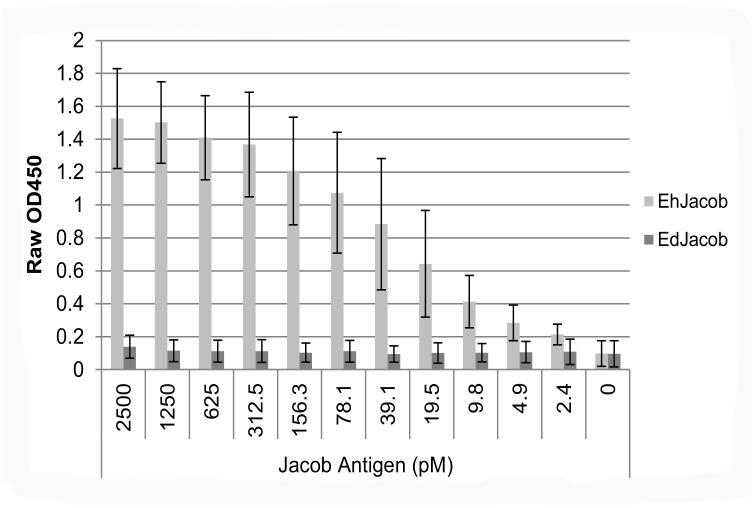
Monoclonal antibodies 1A4 and 1D3 detecting Entamoeba recombinant Jacob2 antigens in a sandwich ELISA.Measured antigen concentration ranged from 2.4–2500 pM. Columns and error bars represent mean OD450 ± standard deviation of three replicate assays. Limit of detection (LOD) was calculated as three standard deviations above the mean OD450 of EdJacob at 2500 pM concentration.